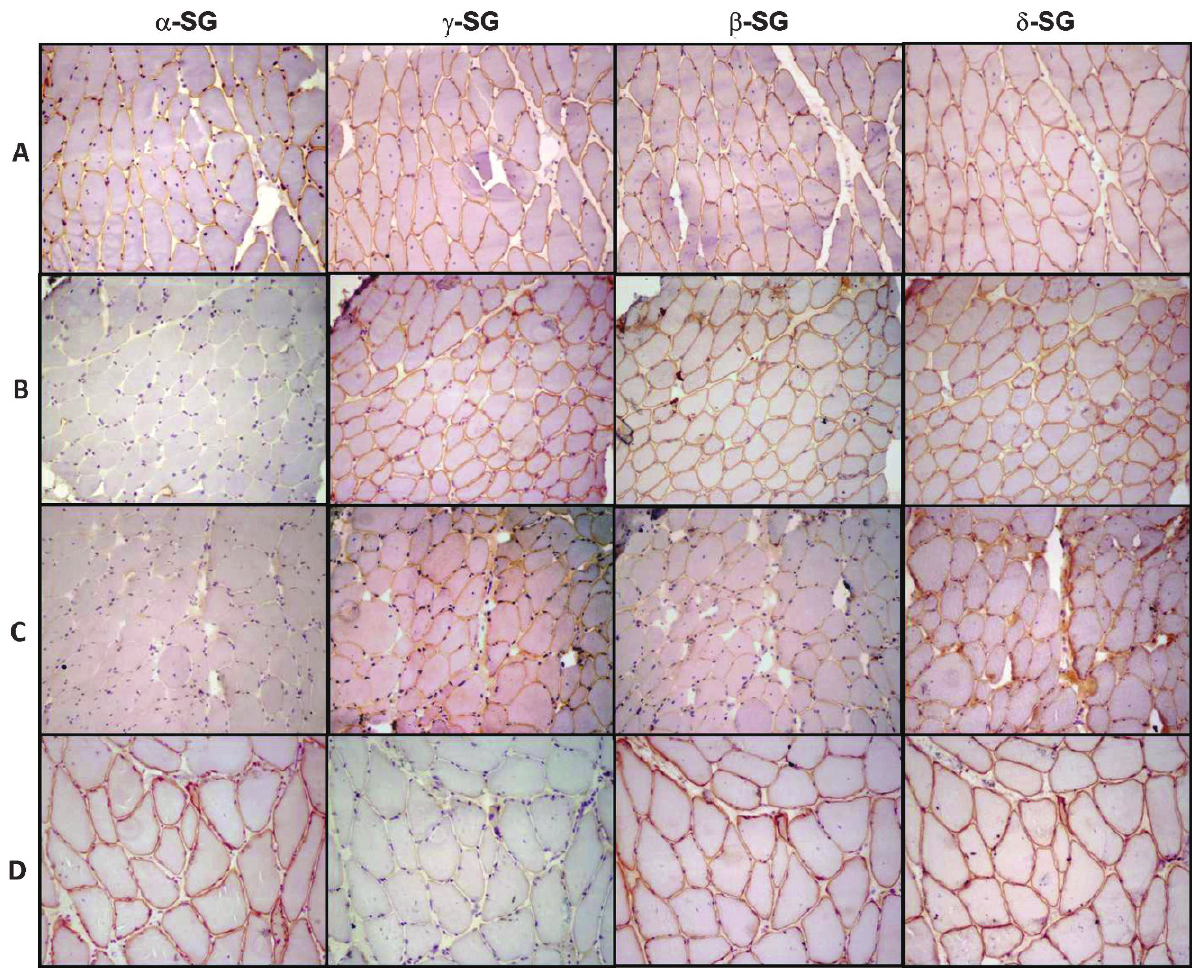
Figure 2 - Immunohistochemical preparations for alpha, gamma, beta and delta sarcoglycans ( a -, c -, b - and d -SG, respectively). (A) A representative non-SGP case showing positive reactions for all four SGs; (B) a representative case of a -SGP showing no expression of a - SG and positive reactions for the remaining SGs; (C) a representative case classified as a -SGP showing patchy expression of all four SGs with lower expression of a -SG; and (D) a representative case of c -SGP showing a negative reaction for c -SG and positive staining for the other three SGs. 200x magnification. SG: sarcoglycan; SGP: sarcoglycanopathy.